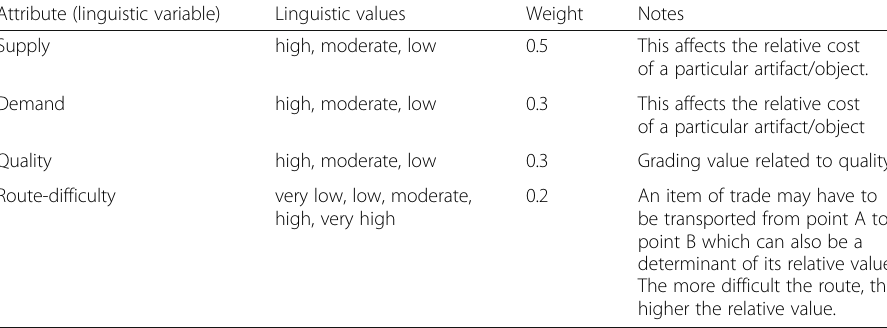
Table 3 Factors for determining the relative-value of an object Attribute (linguistic